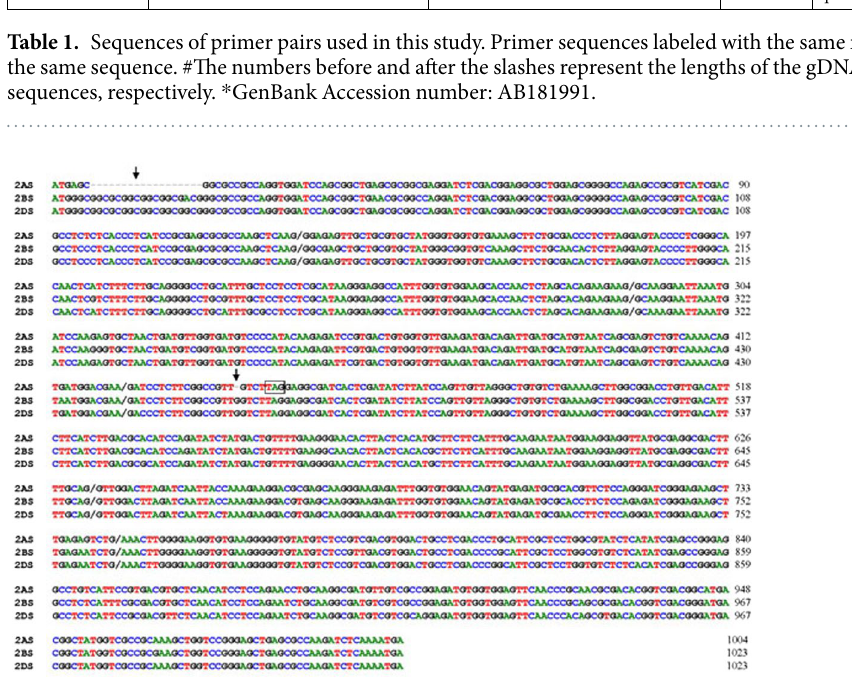
Figure 1. Sequence alignment of ARG cDNAs from the hexaploid wheat accession CB037. 2AS, 2BS, and 2DS represent chromosome names. A slash indicates the intron insertion site. Arrows show the deletions in TaARG located on chromosome 2AS that are not present in the TaARG genes on chromosomes 2BS and 2DS. The in- frame stop codon is shown in the box.